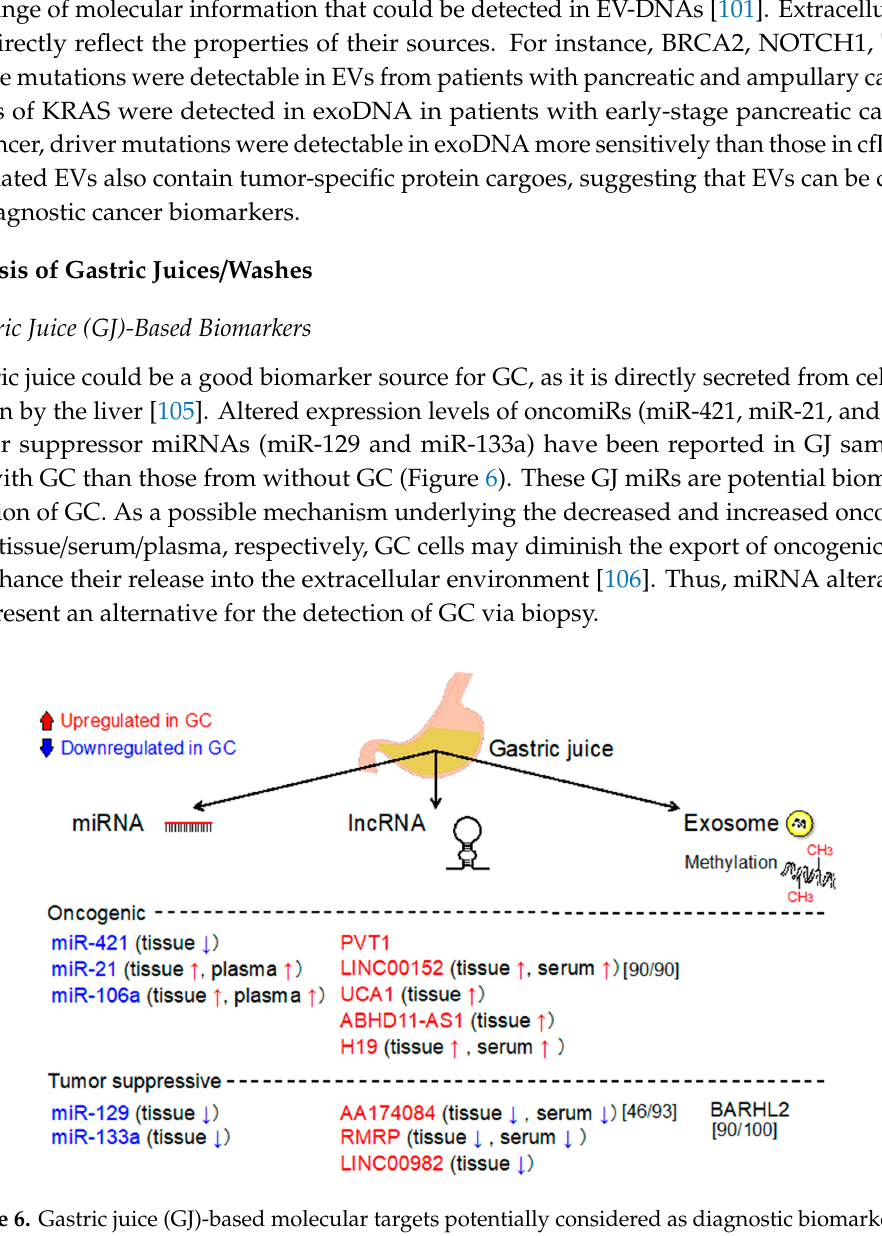
Figure 6. Gastric juice (GJ) ‐ based molecular targets potentially considered as diagnostic biomarkers for GC. Upregulated (in red) and downregulated (in blue) markers are shown. Sensitivity and specificity are shown in square brackets.